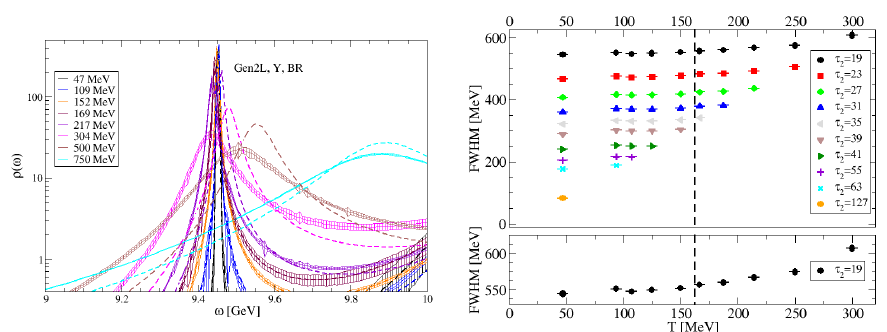
Figure 4. Left: Υ spectral functions from the BR method. The dashed curves denote the spectral functions obtained from truncated correlators at the lowest available temperature, see text for details. The uncertainty bands on these spectral functions (not shown) are of the same magnitude as those from the T > 0 correlators. Right: Υ width from fits using a Gaussian spectral function Ansatz [22]. The top panel shows how the fitted width depends on the final point τ 2 of the fit range for each temperature, while the lower panel shows the width as a function of T using the same fit range for all